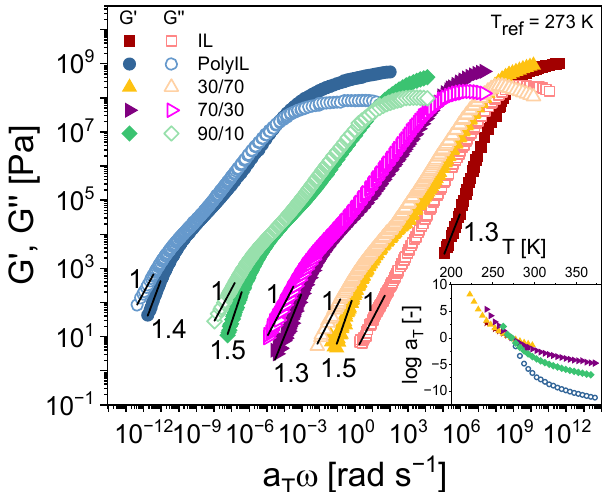
Figure 1. Rheological master curves of five samples (neat ionic liquid (IL), neat polymerized ionic liquid (polyIL), 30 wt% polyIL, 70 wt% polyIL, and 90 wt% polyIL) constructed using time-temperature superposition (TTS) at the indicated reference temperature. The inset displays the TTS shift factors of the sample for T ref = 273 K. TTS was found to work well for all samples as confirmed by the (cid:1853) (cid:3021) shift factors. In